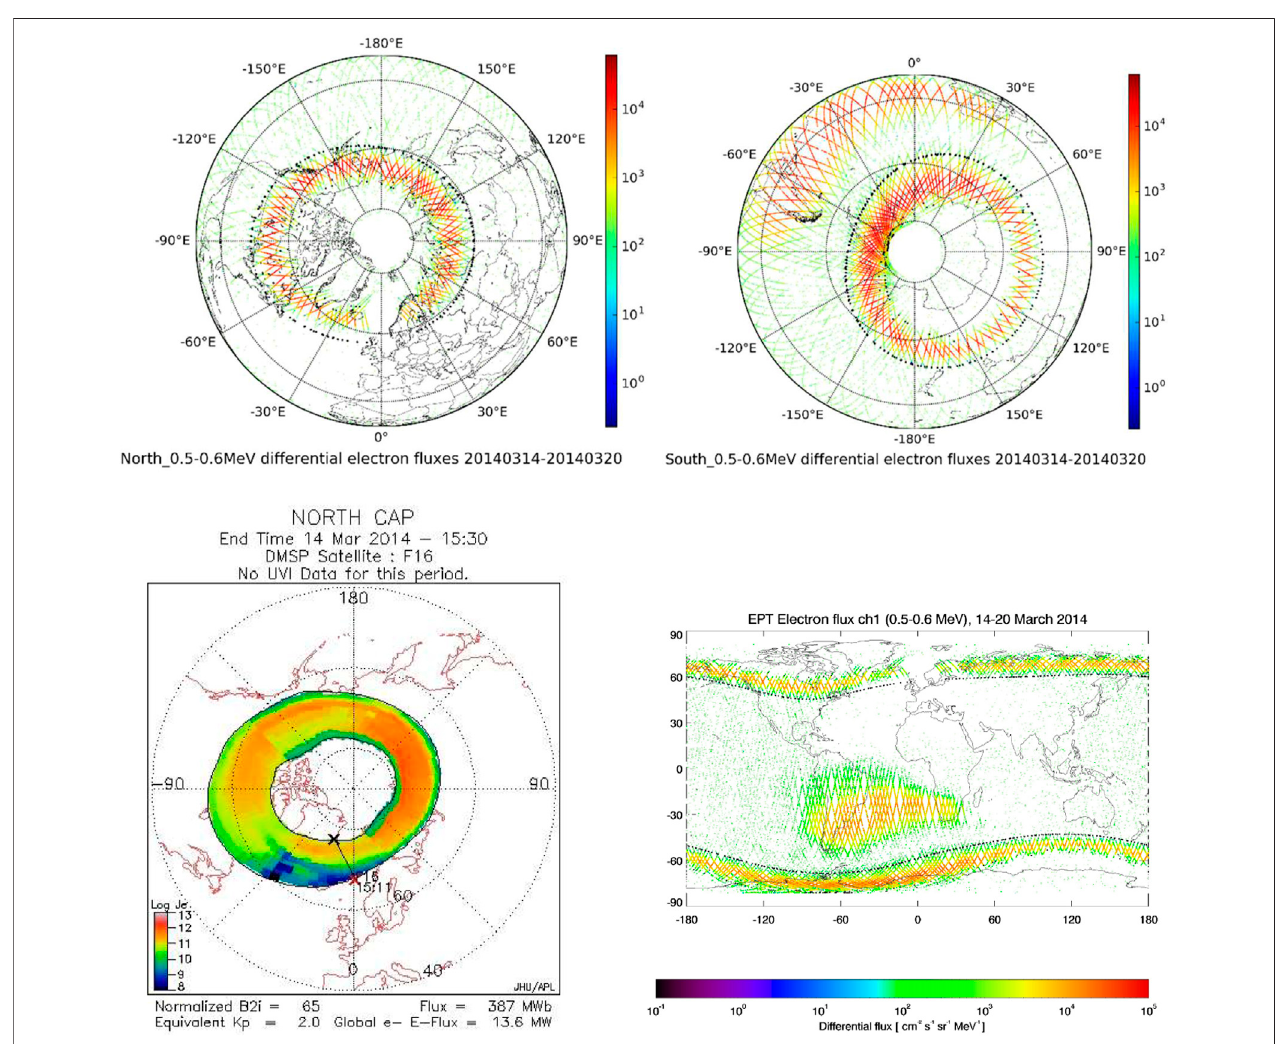
FIGURE 9 | Top panels: EPT observations at 820 km of electron fl uxes 500 – 600 keV from 14 to March 20, 2014 in the Northern hemisphere (left) and Southern hemisphere with the South Atlantic Anomaly SAA (right) . The black circles with increasing radius correspond to constant latitudes of 80 ° , 60 ° and 30 ° . Bottom panels: (Left) The auroral oval as obtained with the OVATION model in the Northern hemisphere for March 14, 2014 at 15h30. The color scale indicates the energy fl ux producing the aurora. The dotted circles correspond to constant latitudes of 80 ° , 60 ° and 40 ° . (Right) The EPT observations of electron fl uxes represented on a latitude/longitudemapwiththeSAAatlowlatitudesandtheouterbeltathighlatitudes.TheblackdotscorrespondtoL (cid:1) 3.5(innerequatorwardedge)andL (cid:1) 8.5(outer polar